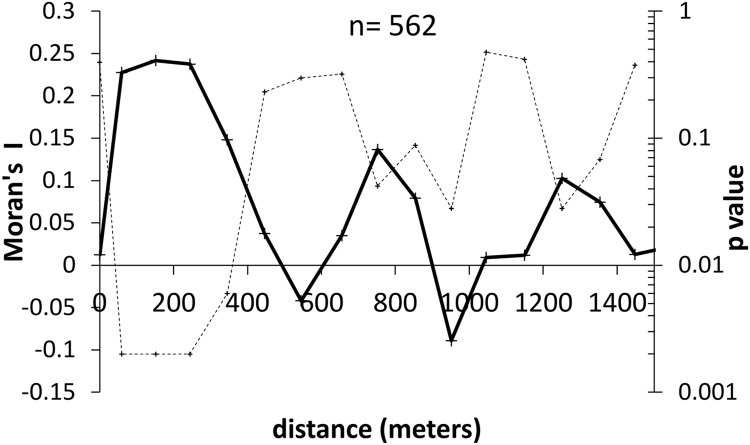
Spatial correlogram of IgG sero-prevalence among controls.Solid line Moran’s I values. Dotted line corresponding p value.